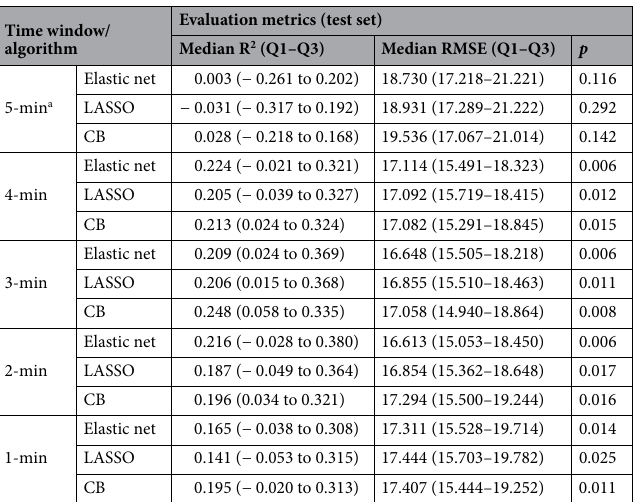
Table 3. Results of the regression models predicting the level of post-experiment subjective fatigue. CB CatBoost regressor, LASSO Least absolute shrinkage and selection operator, p Permutation test p-value, RMSE Root mean squared error. a Please, note that the 5-min time window could not be used in the 2-back